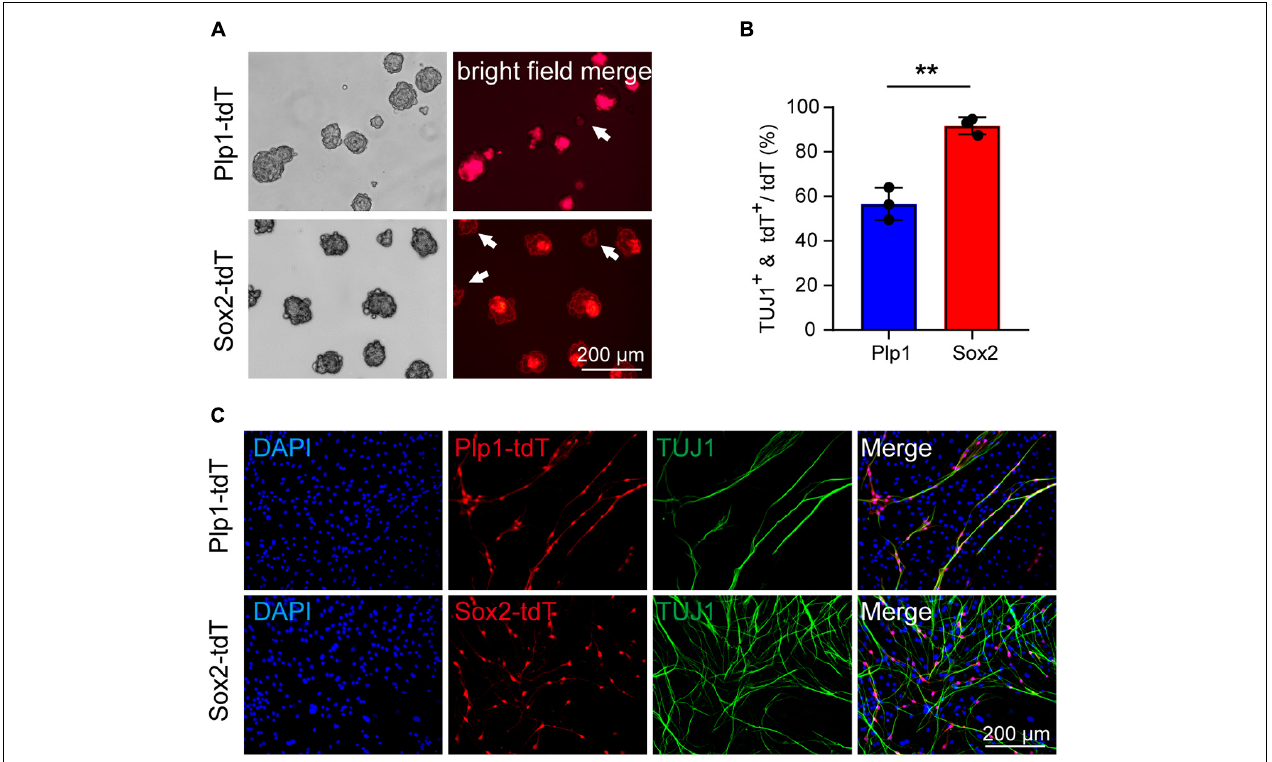
FIGURE 5 | Cochlear Sox2 + glial subpopulation preserves high potency of neuronal differentiation in P21 mice. (A) Representative images of the Sox2-tdT and Plp1-tdT positive spheres culture 5 div. The white arrow represents the Plp1-tdT or Sox2-tdT negative spheres. (B,C) Representative images (C) and ratios (B) of TUJ1+ neurons differentiated from Sox2-tdT or Plp1-tdT positive cells. N = 3, error bars represent mean ± SD. ** p < 0.01 by unpaired student’s t